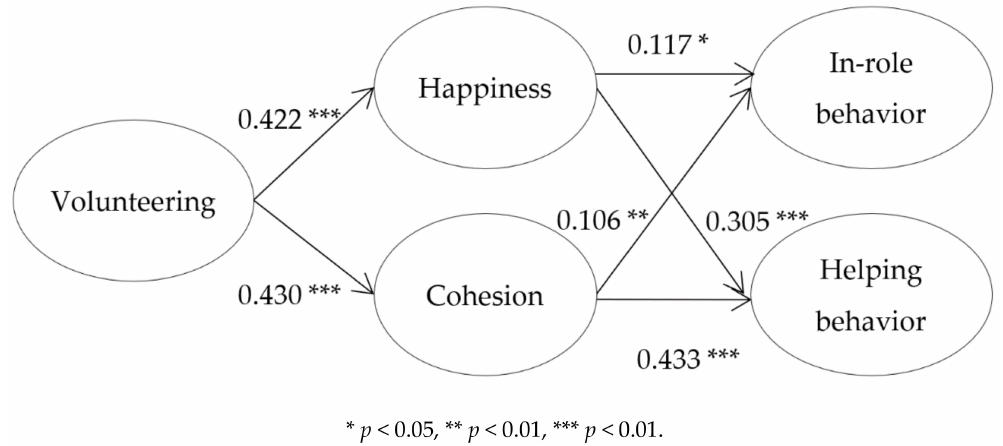
Figure 1. Estimates of the structural mediation